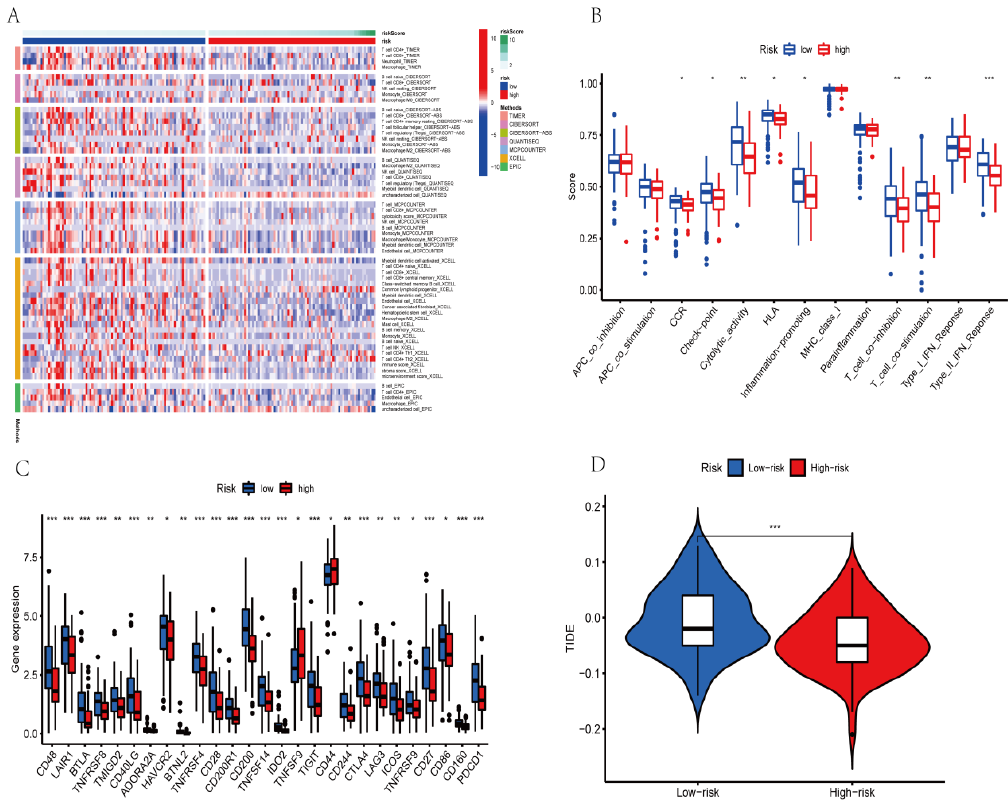
Figure 9. Immune cell infiltration analysis of PAAD patients in high-risk and low-risk groups. (* p < 0.05; ** p < 0.01; *** p < 0.001) ( A ) Immune cell variations between low-risk and high-risk groups based on different algorithms. ( B ) Immune function ssGSEA scores. Differences between low-risk and high-risk groups for ( C ) the immune checkpoints and ( D ) TIDE